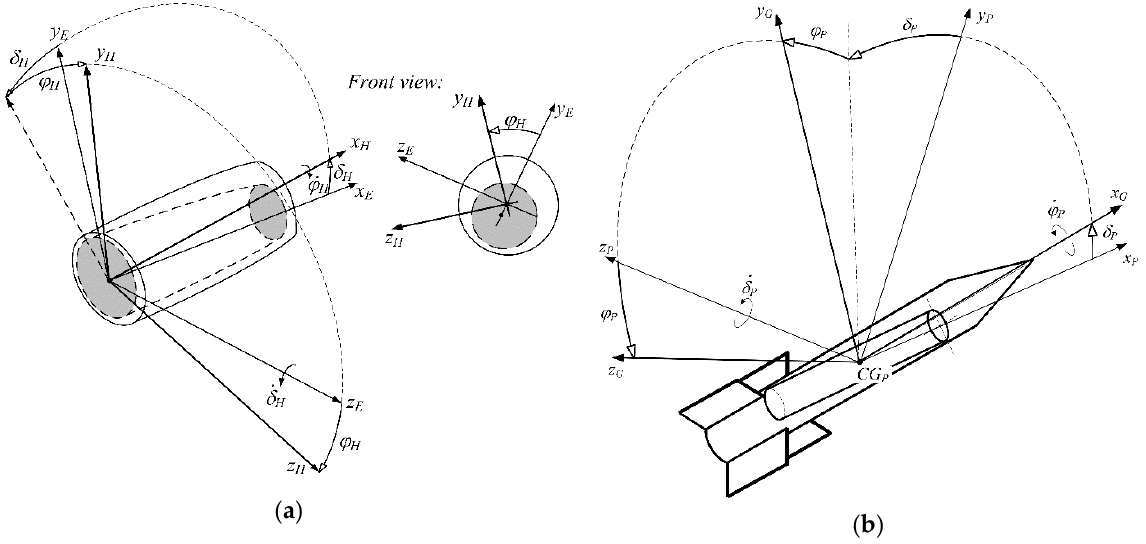
Figure 3. ( a ) The warhead error [12]; ( b ) the propellant error.